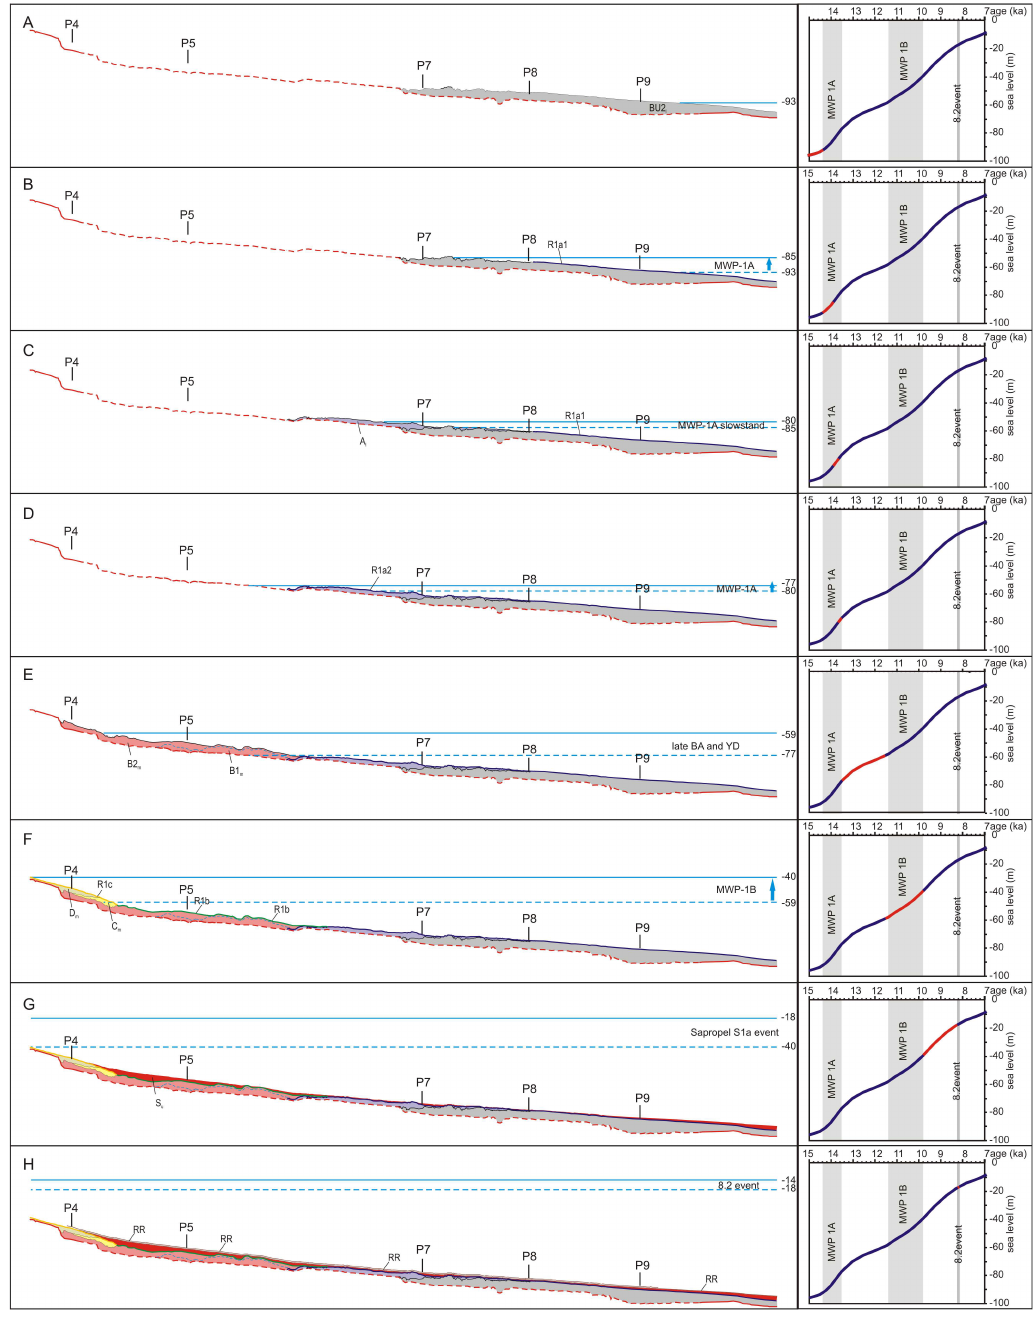
Figure 13. Phases of deposition of the UBSUs reported in profile T1 and plotted on the sea level curve by [45] (right side). For the description of the steps ( A – H ), see the text. BA = Bølling Allerød; YD = Younger